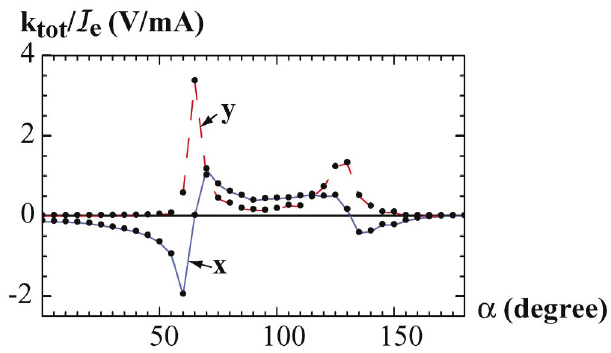
FIG. 14. (Color) Total kick in x (solid) and y (dashes) experi- enced by a test particle (on crest) as function of dark-current emission angle (cid:17) . For the calculation a fine macroparticle emission spacing was used ( (cid:23) (cid:22) (cid:2) 0 : 1 (cid:7)